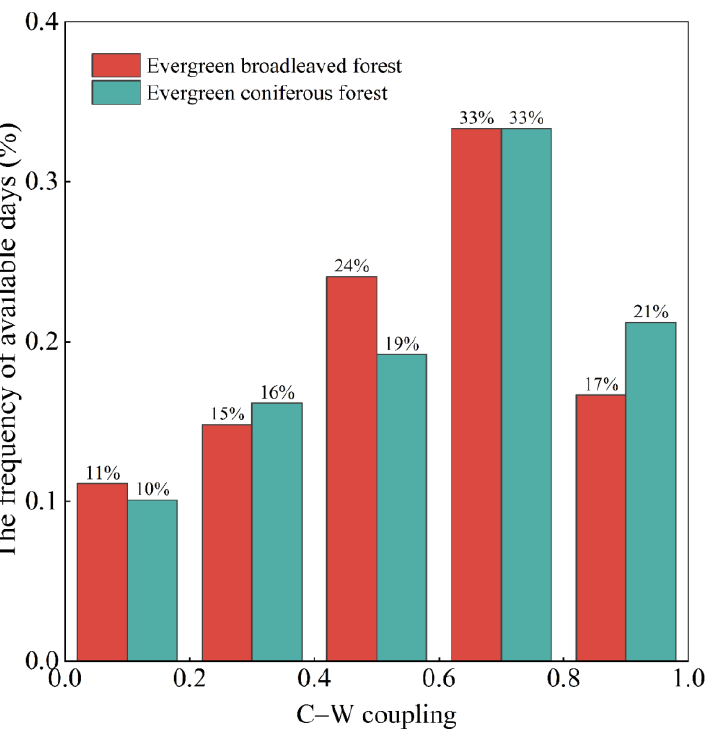
Figure 6. Histogram of diurnal C – W coupling in the broadleaved forest at Dinghushan and in the coniferous forest at Qianyanzhou on summer no-rain days over 2003 – 2005.